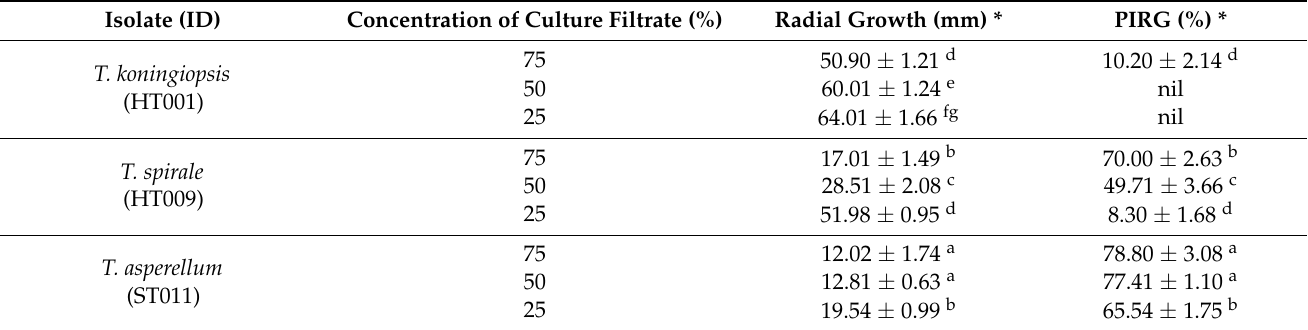
Table 5. Effects of three different concentrations of culture filtrate containing non-volatile metabolites produced by four Trichoderma isolates on Rigidoporus microporus radial growth and the percentage inhibition of radial growth (PIRG) after 5 days of growth at 28 ± 2 ◦ C, in the